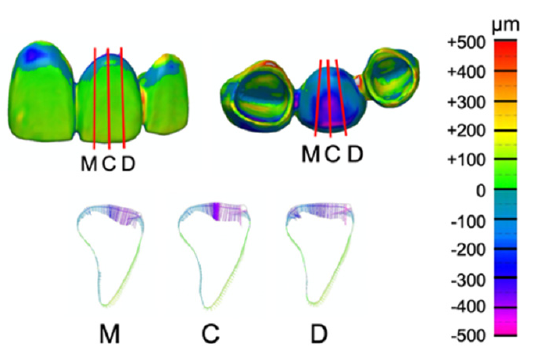
Figure 7. Created “cross-sections” with morphometry software. Mesial cross-section (M). Central cross-section (C). Distal cross-section (D).